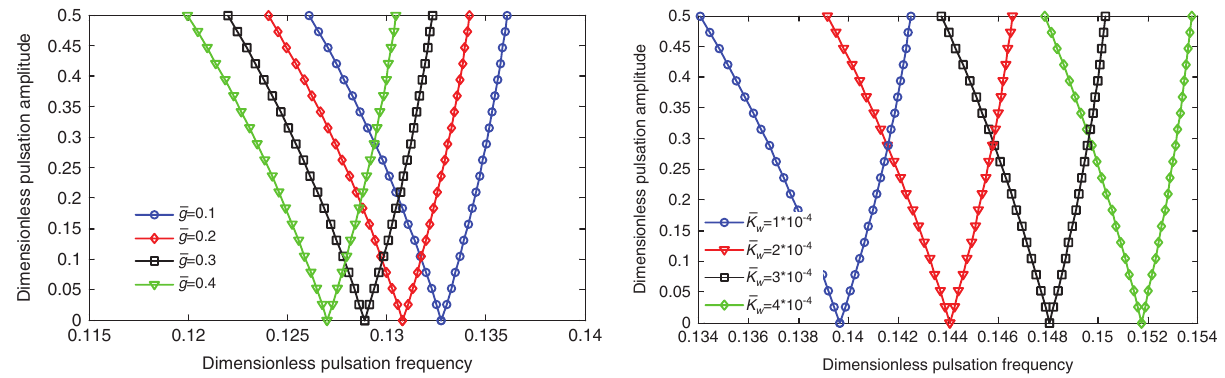
Figure 8: Effect of the viscoelastic material damping coefficient on the dimensionless pulsation amplitude versus dimensionless pulsation frequency.